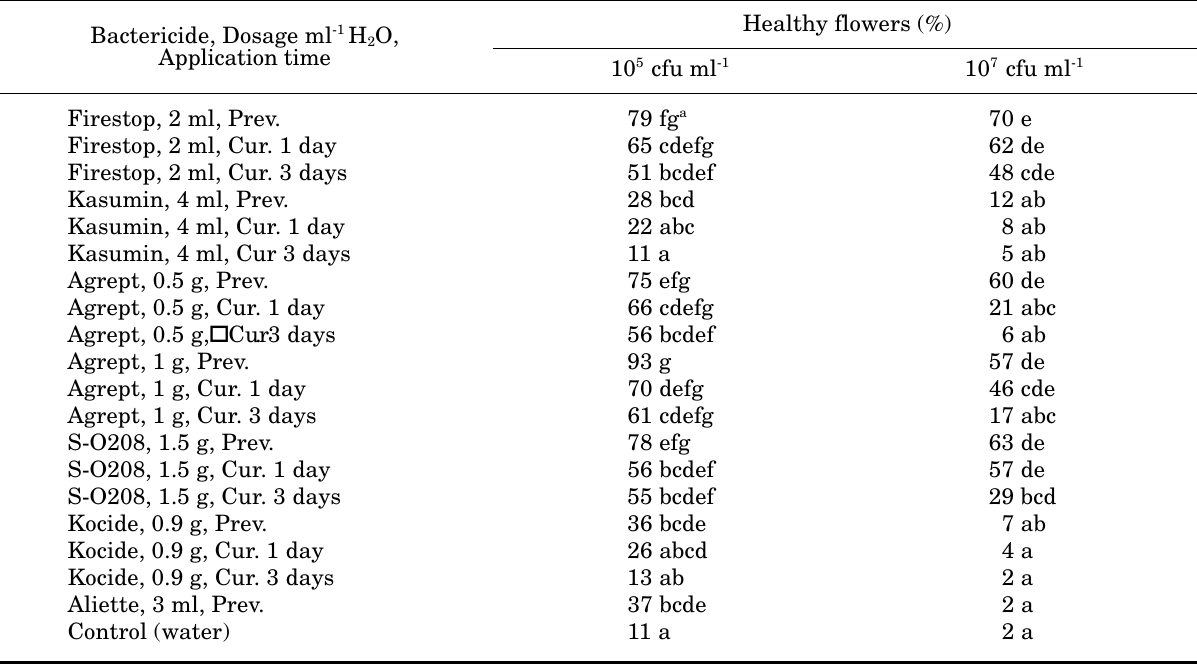
Table 3. Effectiveness of preventive (Prev.) and curative (Cur.) sprays on pear flowers (var. Kristalli) artificially inoculated with Erwinia amylovora at concentrations of 10 5 and 10 7 cfu ml -1 in